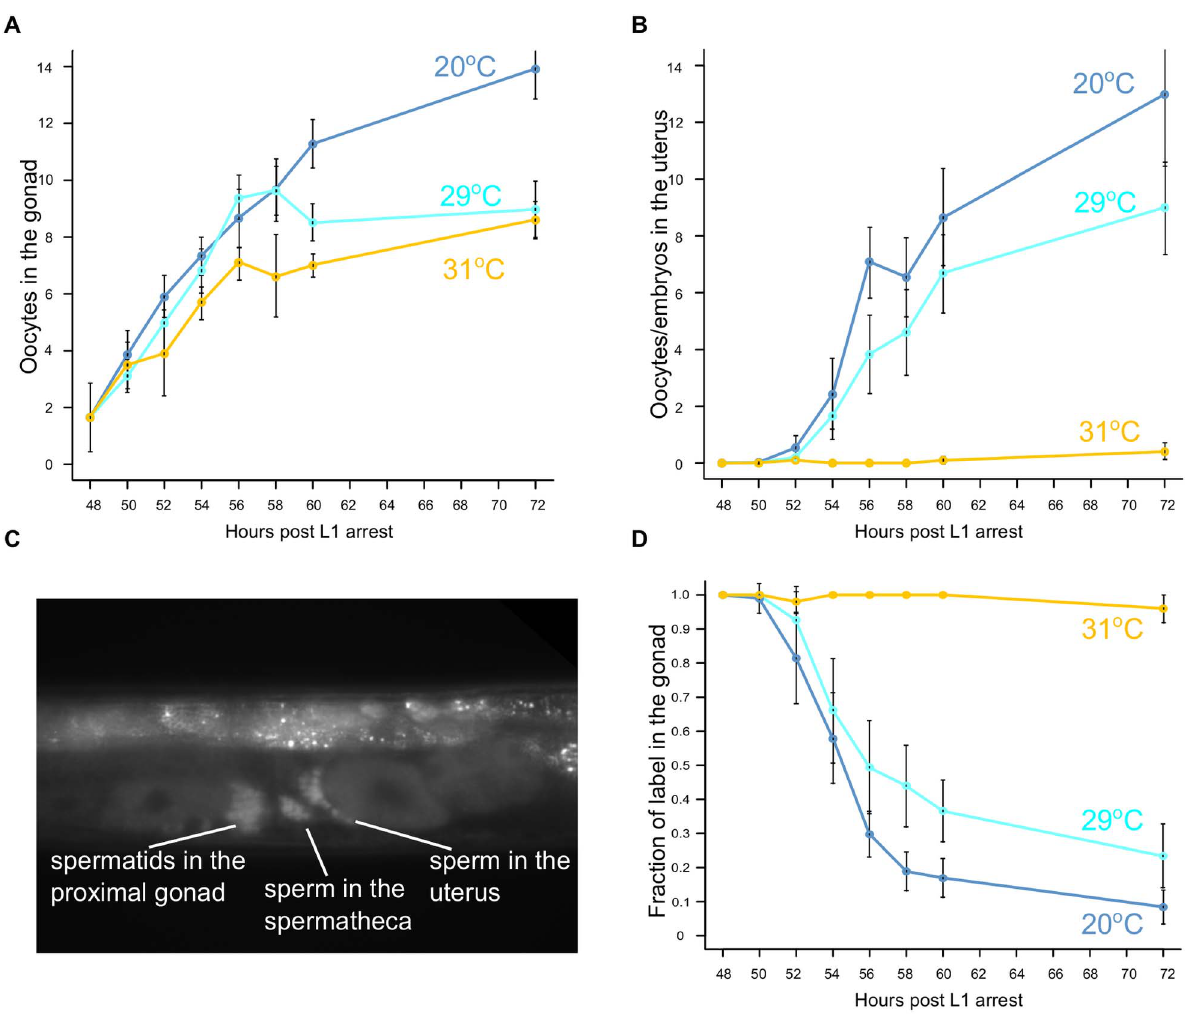
Figure 5. Oocyte production, ovulation, and spermatid transit at different stress temperatures. (A) Oocyte production at stress temperatures (29 u C and 31 u C) compared to the 20 u C control. (B) Ovulation at stress temperatures (29 u C and 31 u C) compared to the 20 u C control. (C) A representative image of mCherry-expressing spermatids and sperm in a young adult (54 hours post L1 arrest) hermaphrodite, showing the partitioning of labeled cells between the proximal gonad and the spermatheca and uterus. (D) Transit of spermatids from proximal gonad at stress temperatures (29 u C and 31 u C) compared to the 20 u C control. Error bars represent s.d.